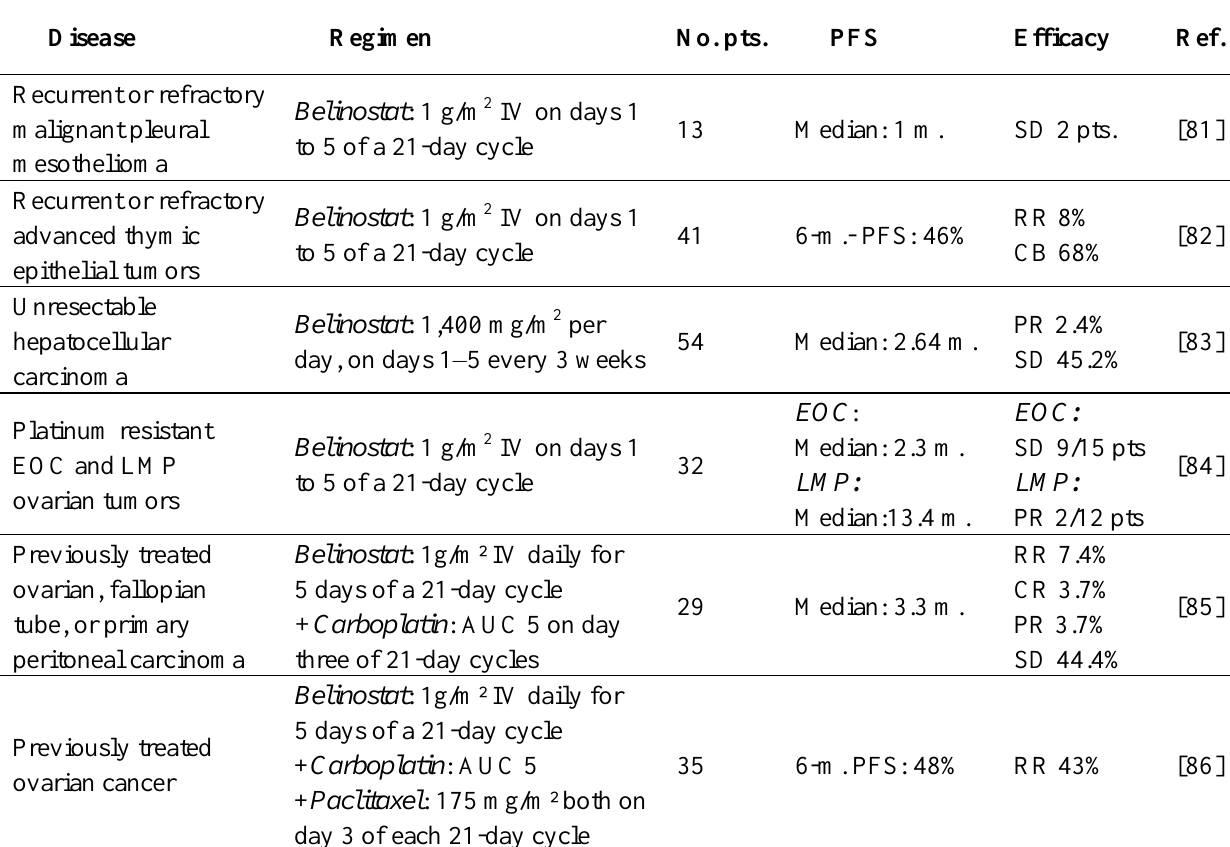
Table 4. Belinostat in published phase II clinical trials in solid